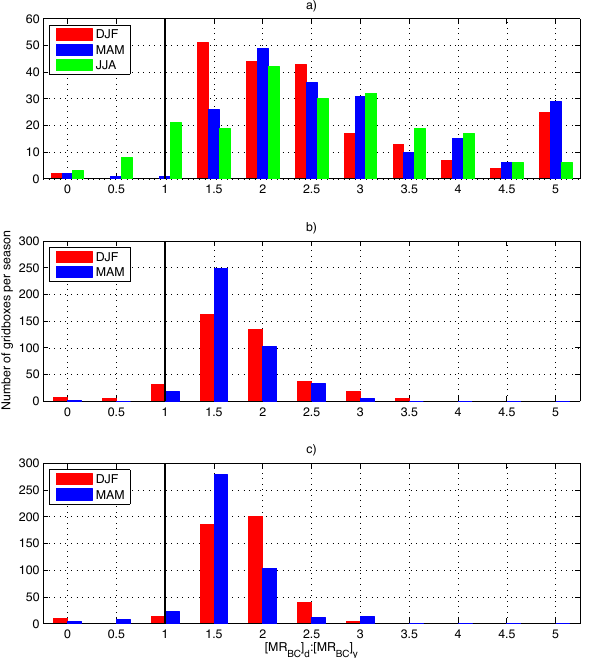
Figure 4. Histograms of the ratios [MR BC ] d :[MR BC ] y for all grid boxes in the regions around (a) Greenland, (b) Eurasia and (c) North America. Shown are seasonal averages for winter (DJF), spring (MAM) and summer (JJA; Greenland only) of daily values when the offline calculations use CESMmet. The ratios [MR BC ] d :[MR BC ] y >5.0 are allocated to the 5.0 bin (see Fig. S1–S3 for maps of the seasonal averages of [MR BC ] d :[MR BC ] y in each model grid box in these three regions).